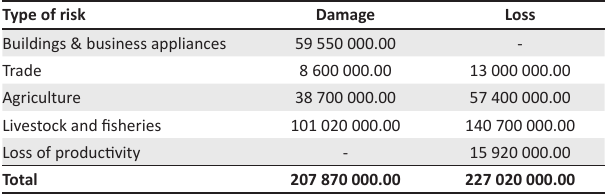
TABLE 6: The economic valuation of flood risks in Klaten. Type of risk